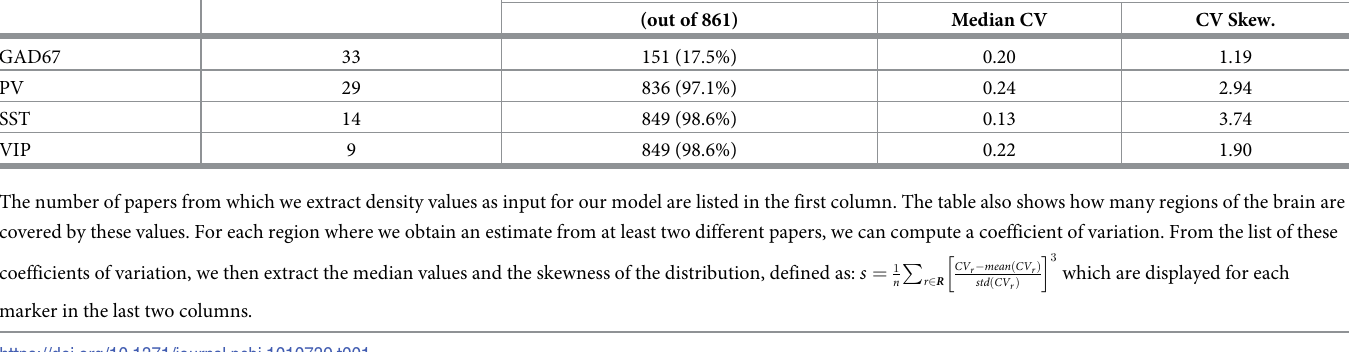
marker in the last two